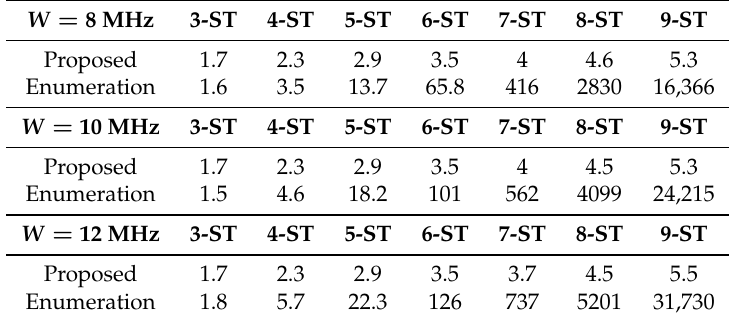
Table 1. Comparison of the computation time (in seconds). The results are obtained on a PC